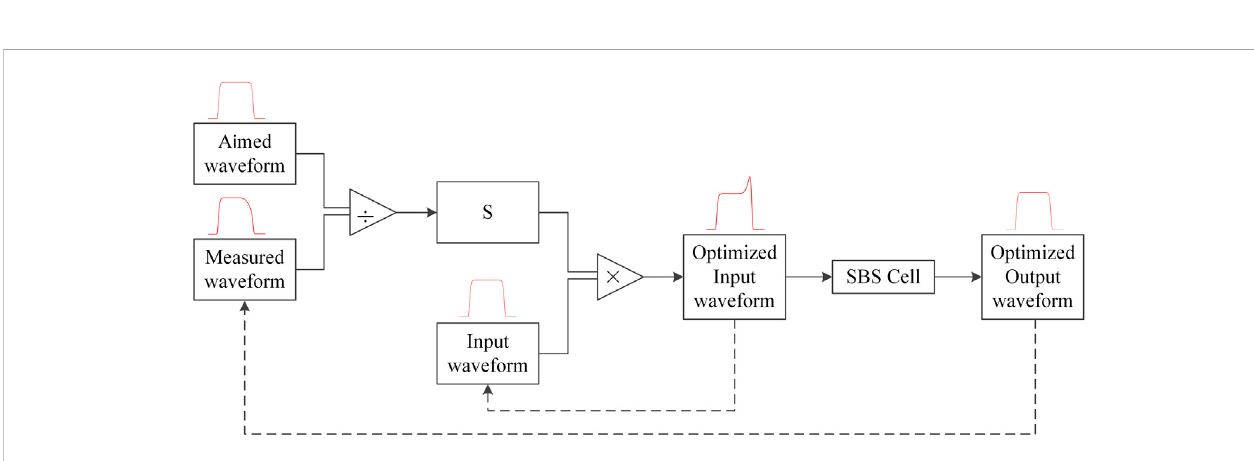
FIGURE 2 The process of the waveform